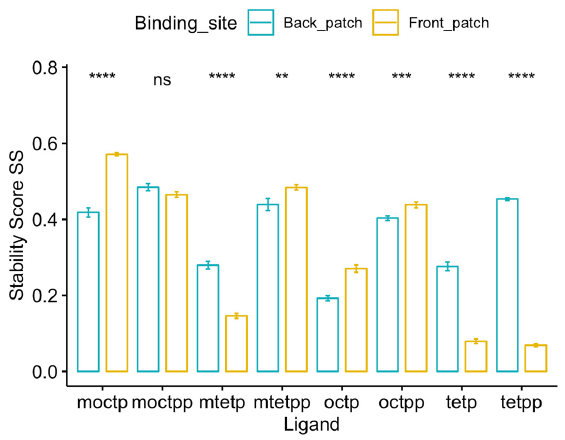
Figure 4. Stability score SS analysis of 8 ligands bound to front-patch and back-patch binding positions of DM- Act KR. Among all 4 octaketide ligands, 3 of them (m-oct-p, oct-pp, oct-p) showed a significantly higher SS at front-patch. While among all 4 tetraketide ligands, 3 of them (m-tet-p, tet-pp, tet-p) show significantly higher SS at back-patch. Significance levels: ns, p > 0.05; *, p <= 0.05; **, p <= 0.01; ***, p <= 0.001; ****, p <= 0.0001.